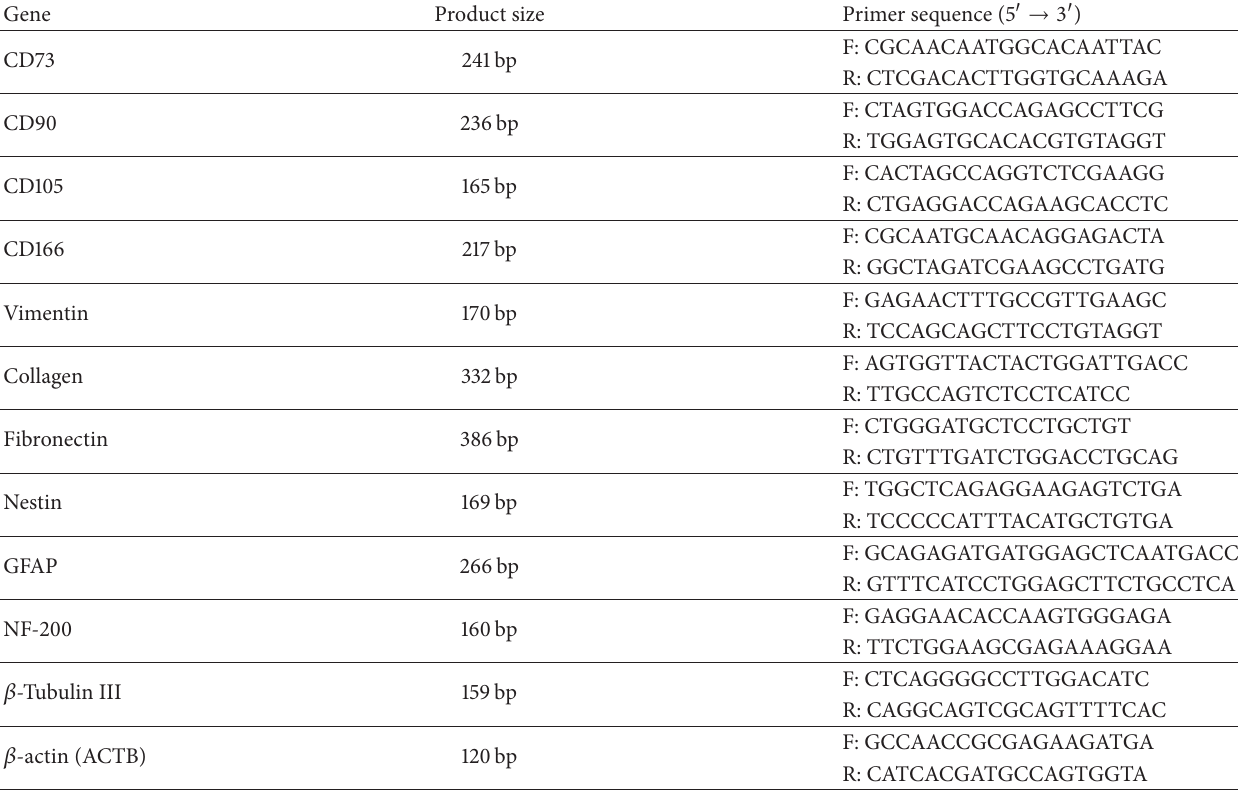
Table 2: Primers used for quantitative